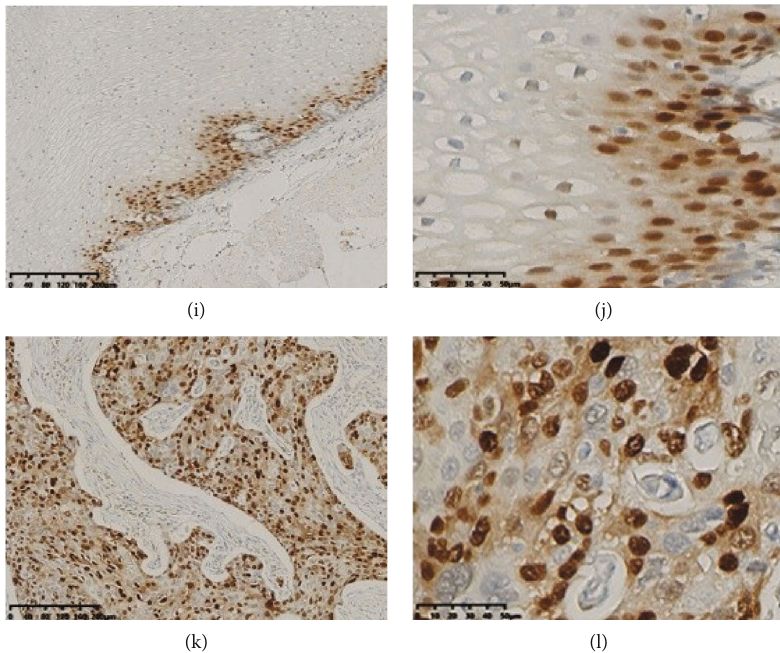
Figure 1: IHC staining of MACC1, c-Met, and cyclin D1 in ESCC tissues and normal esophageal mucosa. Notes: (a) MACC1-negative expression in normal esophageal tissues ( × 10); (b) MACC1-negative expression in normal esophageal tissues ( × 40); (c) MACC1-positive localized in cytoplasm expression in ESCC ( × 10); (d) MACC1-positive expression in ESCC ( × 40); (e) c-Met-negative expression in normal esophageal tissues ( × 10); (f) c-Met-negative expression in normal esophageal tissues ( × 40); (g) c-Met-positive expression localized in the cell cytoplasm and cell nucleus in ESCC ( × 10); (h) c-Met-positive expression in ESCC ( × 40); (i) cyclin D1 expression in mucosal basal lamina cells of normal esophageal tissues ( × 10); (j) cyclin D1-negative expression in normal esophageal tissues ( × 40); (k) cyclin D1-positive localized in nucleus expression in ESCC ( × 10); (l) cyclin D1-positive expression in ESCC ( × 40). Abbreviations: ESCC: esophageal squamous cell carcinoma; IHC: